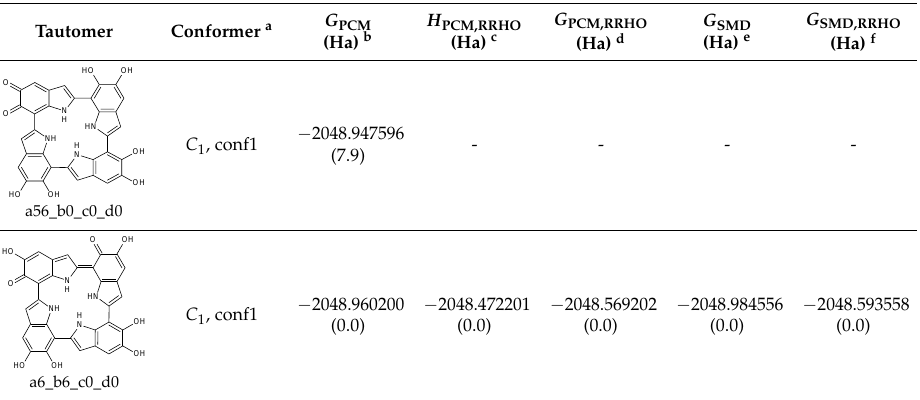
Table 8. KP-2e, neutral form in water.